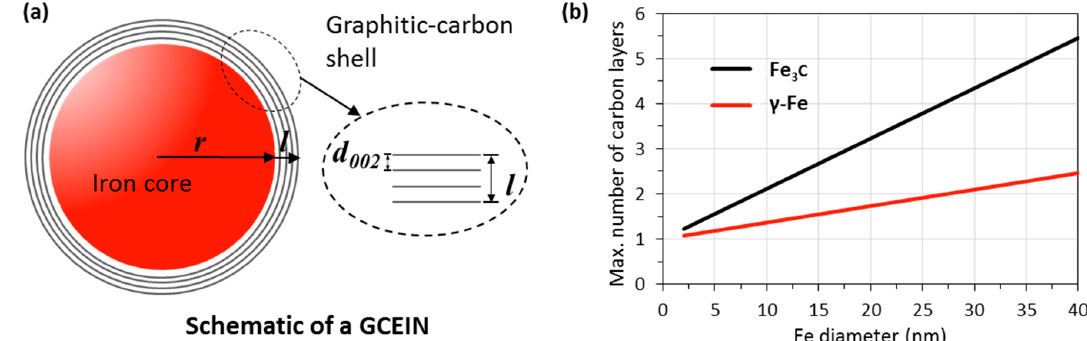
Figure 6. ( a ) Schematic of a graphitic-carbon-encapsulated iron nanoparticle (GCEIN) model and ( b ) estimated maximum number of graphene-layers vs the diameter of iron nanoparticles.